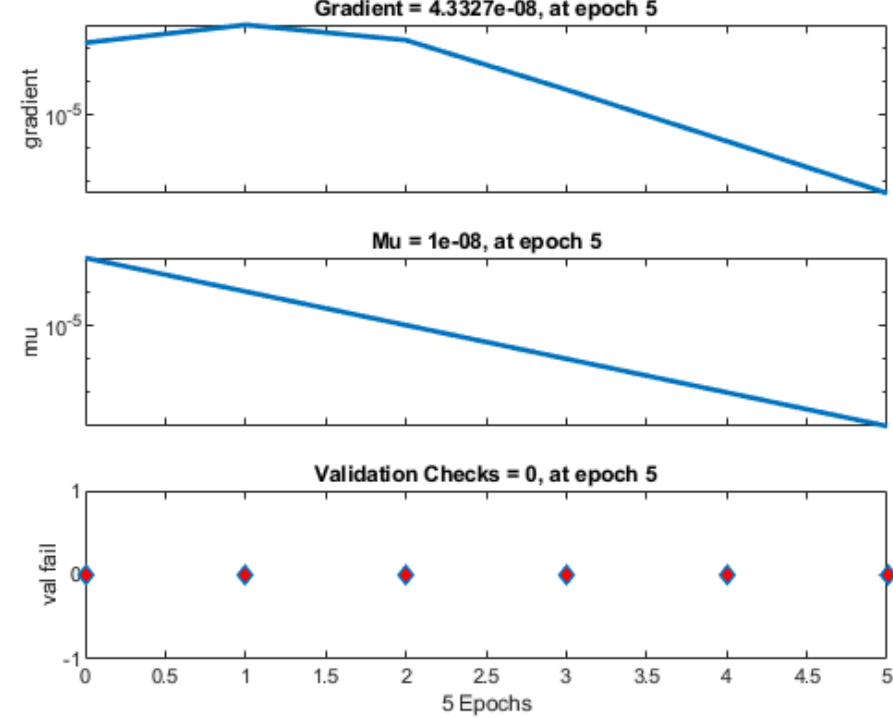
Figure 42. Neural network controller training performance.